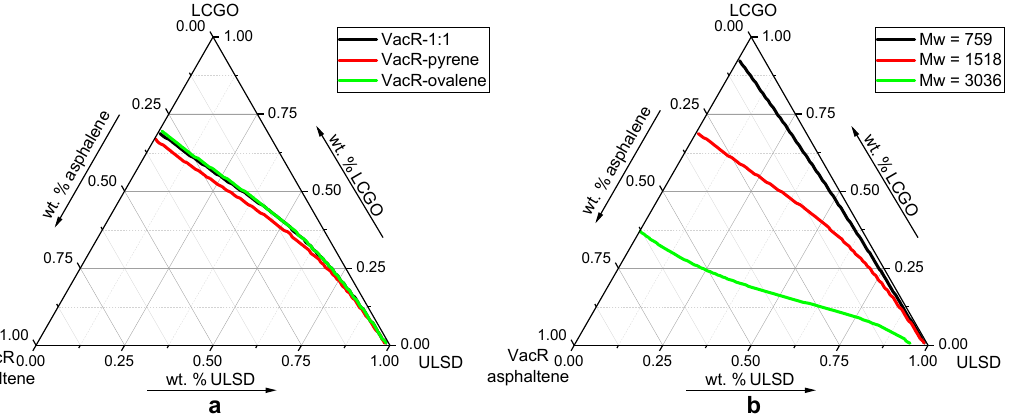
Figure 3. Three-component phase diagrams (the composition is indicated in mass fractions): ( a ) the effect of the group composition of asphaltene on its solubility; ( b ) influence of asphaltene molecular weight on the solubility isotherm.